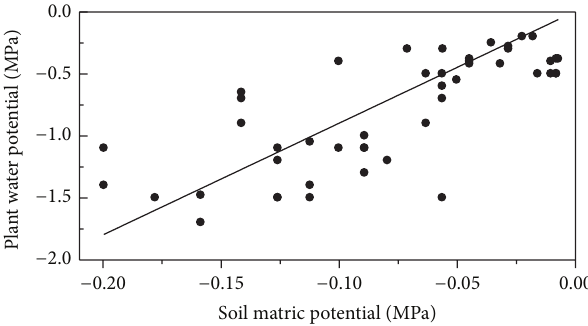
Figure 2: Relation between the measured predawn leaf water potential and the calculated soil matric